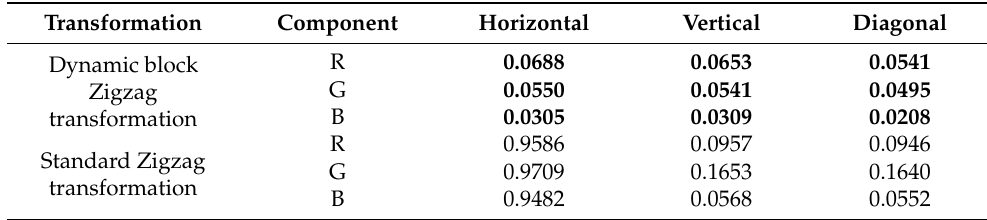
Table 1. Correlation coefficients of neighboring pixels after different Zigzag transformations (The bold part is the relevant value of the proposed algorithm.). Transformation Component Horizontal Vertical